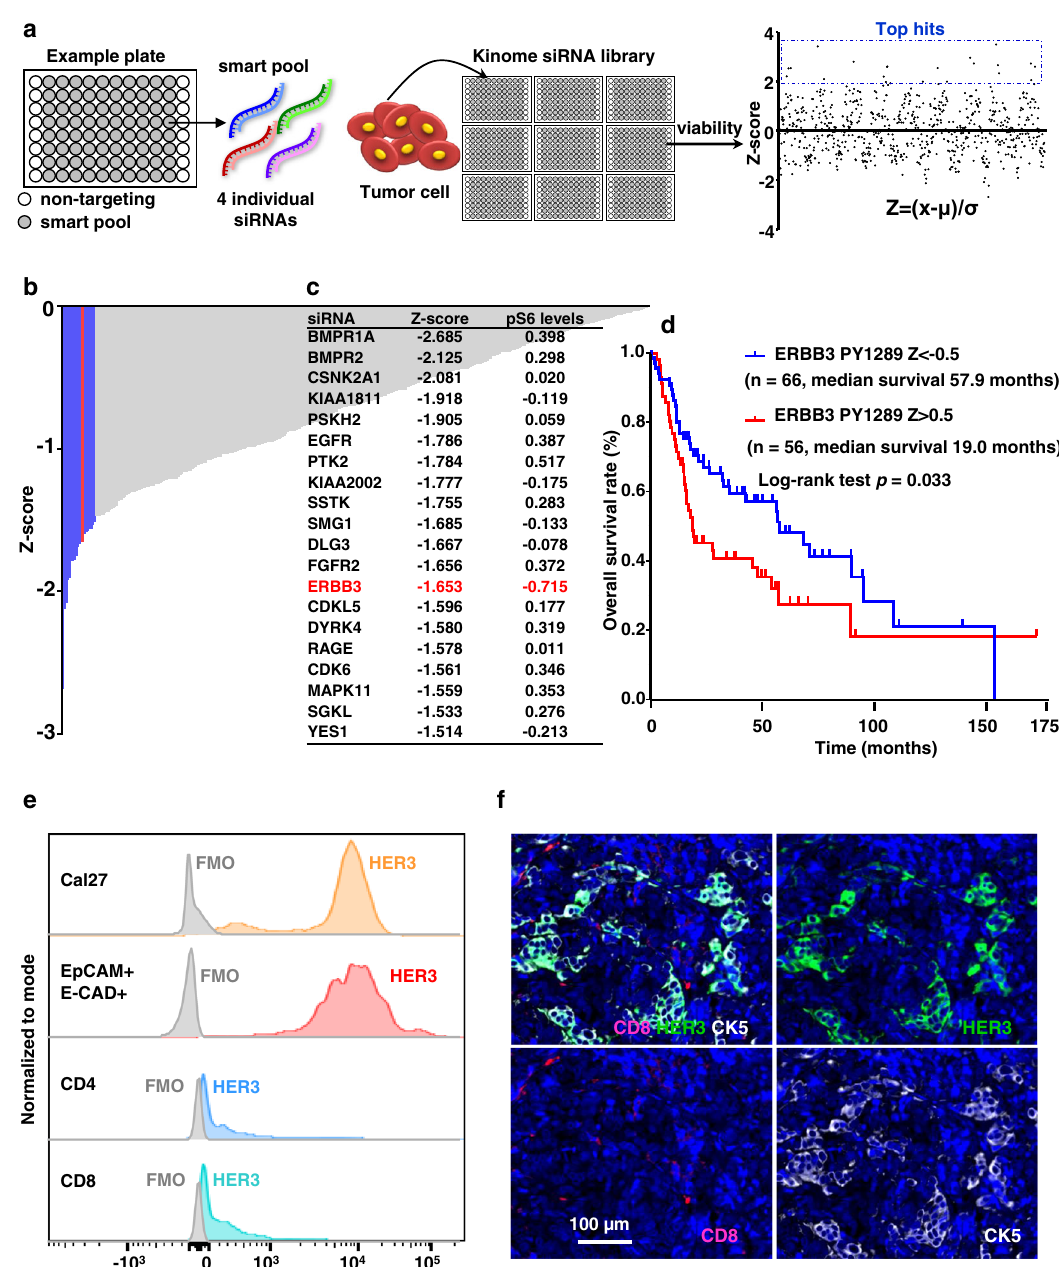
Fig. 1 HER3 is a candidate driver of the PI3K/mTOR oncogenic signaling circuitry in HNSCC. a Experimental scheme of the kinome siRNA library screen. A “ smart pool ” of four individual siRNAs targeting each protein kinase gene of the human kinome is distributed in each well of the experimental plates. Cal27 cells were incubated for 72 h and assayed for cell viability, and the Z -score for viability was calculated ( Z = (x − µ )/ σ ) (x stands for each value of cell viability; µ stands for average value; σ stands for standard deviation). b siRNA library targeting human kinases using the kinome siRNA library with Cal27 cells was conducted to search for genes that affect proliferation of HNSCC. Shown are the genes whose knockdown decrease cell viability ( Z -score). The blue are the top 20 genes and HER3 is shown in red. (See Supplementary Data 1 for complete list). c Cal27 cells were transfected with the corresponding siRNAs (top 20 hits) for 72 h and cell lysates were analyzed for pS6 by western blotting. Densitometry analysis of western blots was performed using ImageJ. Shown are the top 20 hits of the kinome siRNA screen and their Z -scores, together with changes in pS6 levels after each gene was knocked down, as compared to the non-targeting siRNA group. Similar levels of S6 and GAPDH as loading control were con fi rmed (Supplementary Fig. 1). d The TCGA (The Cancer Genome Atlas) database was used to determine the relationship between HER3 phosphorylated on tyrosine 1289 (PY1289) and overall survival (OS) ( n = 122 HNSCC patients, two sided log-rank test; p = 0.033). e Histogram demonstrating HER3 expression in EpCAM + E-CAD + tumor cells (red) and tumor-in fi ltrating CD4 + and CD8 + T cells (blue) in a fresh surgical specimen from a Stage II T2N0M0 primary tongue squamous cell carcinoma, compared to Cal27 cells (orange) as control. FMO ( fl uorescence minus one) samples were used to create HER3 + staining gates. f Immuno fl uorescent staining of CK5, CD8, and HER3 in the same specimen in panel ( e ), showing HER3 co-expressed with cancer cells (CK5 positive), but not with CD8 + T cells ( n = 1 patient). Source data are provided as a Source Data fi